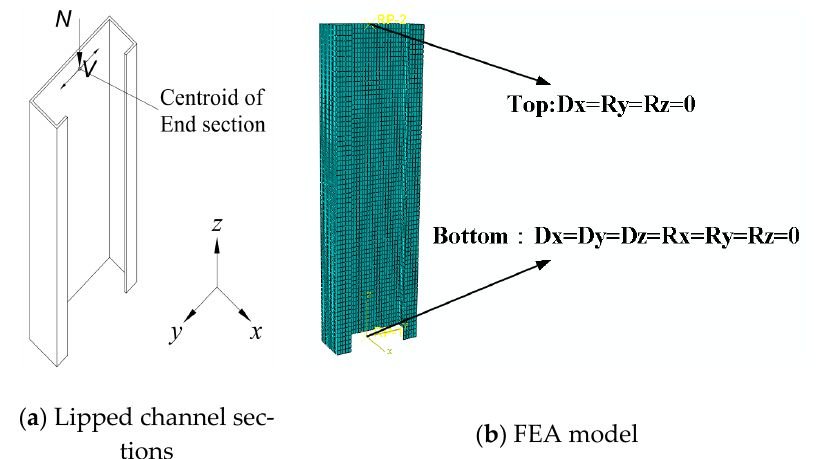
Figure 2. FEA model diagram. ( a ) Lipped channel sec-tions, ( b ) FEA model